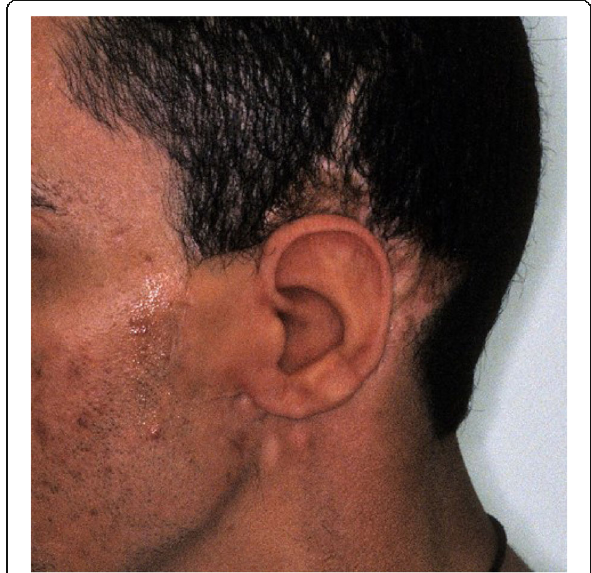
Fig. 11 Lateral view of the completed prosthesis